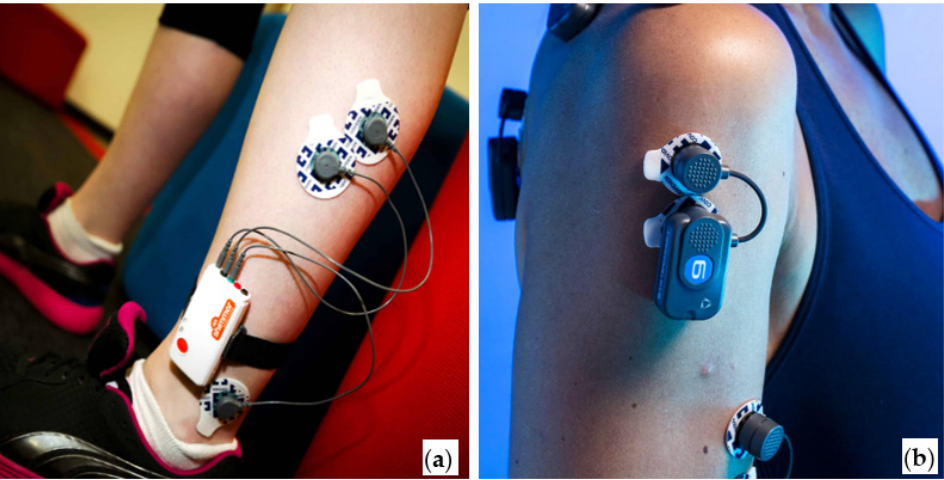
Figure 14. Applications of the Shimmer3 EMG ( a ) and FreeEMG ( b ) sensors on the legs and shoulder for monitoring body movements (Web-source: https://www.biometricsltd.com/surface-emg-sensor.htm ( a ), https://www.medicalexpo.com/prod/biometrics/product-123702-880665.html ( b ), every aspect related to the human subjects’ involvement has been taken into consideration by Shimmer Co. (Dublin, Ireland) and BTS S.p.A. (Garbagnate Milanese, MI Italy), respectively) (Image courtsey by Shimmer Co. (Dublin, Ireland) and BTS S.p.A. (Garbagnate Milanese, MI Italy), respectively).